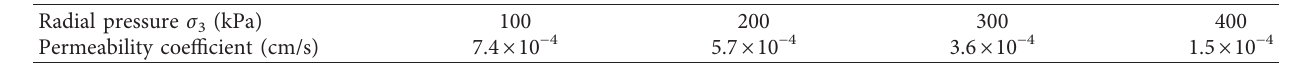
Table 2: Loess permeability test results.